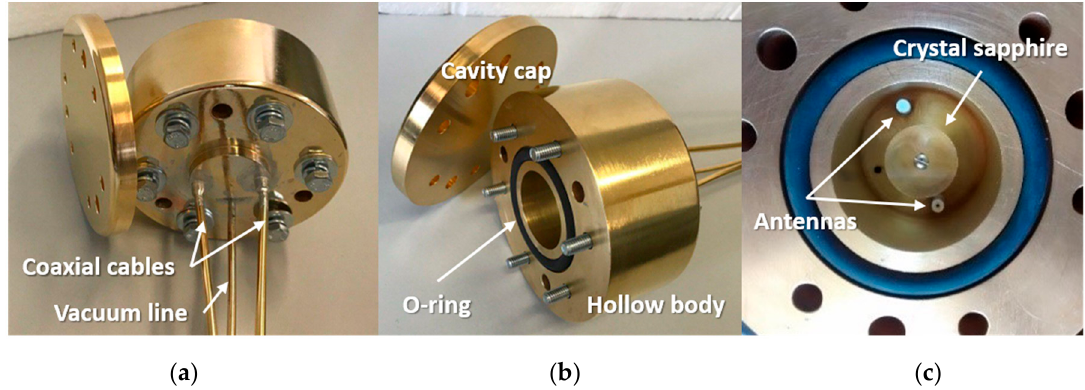
Figure 1. SWGT prototype fabricated. The three panels in the figure report different views of the device: ( a ) top part of the cavity with the two coaxial cables brazed and the vacuum line; ( b ) bottom part of the cavity without the cap, the sealing O-ring and six bolts are visible) and ( c ) 17.6-mm crystal sapphire placed inside the cavity (external diameter = 100 mm) with the exciting antennas.